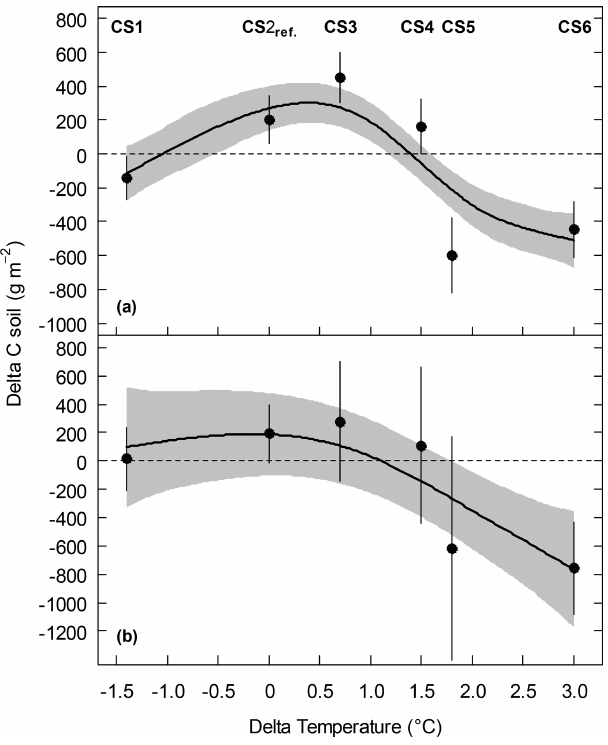
Figure 1. SOC stock change (Delta C soil) of subalpine grass- land between 2012 and 2017 at six climate scenario sites (CS) as a function of the temperature change (Delta temperature of the April–October mean) induced by the climate change treatment. (a) All monoliths, pooled across the irrigation and N treatments, and (b) control monoliths only that received neither irrigation nor additional N. Symbols are means ± 1SE, and predicted lines are based on a generalized additive model (GAM) to all monoliths per group ( ± 1SE, grey shaded). See Appendix Table B4 for the GAM summary.